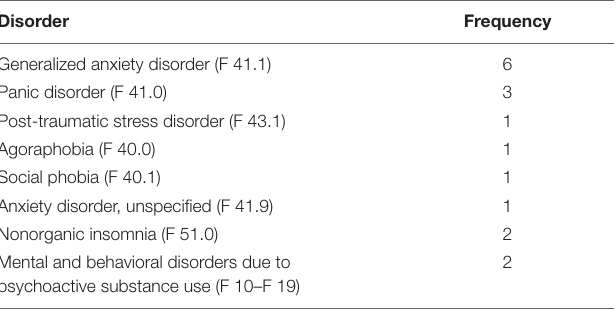
TABLE 3 | Characteristics of improvers and non-improvers in everyday